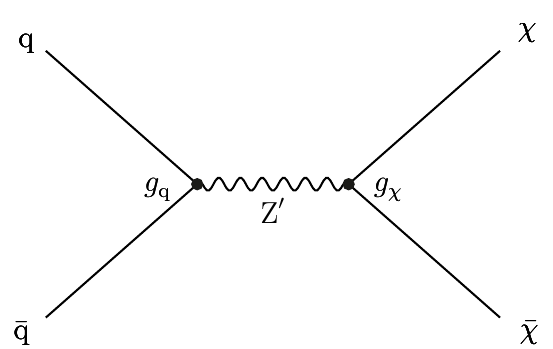
Figure 1 . Feynman diagram of leading-order resonant production of dark quarks through a Z 0 mediator. The relevant couplings to SM quarks and dark quarks, g labeled